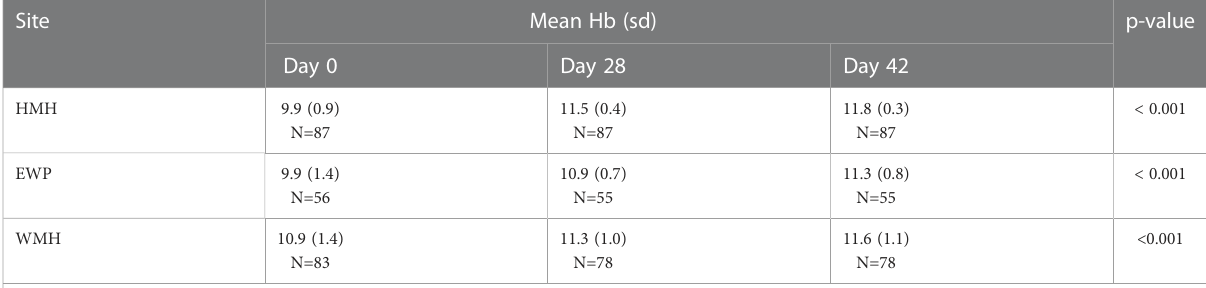
TABLE 4 Changes in mean hemoglobin levels following treatment with DHAP.